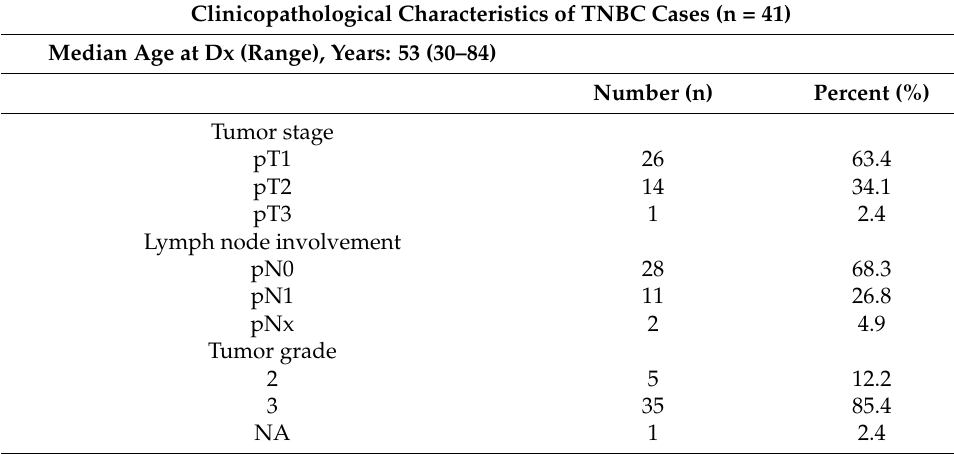
Table 1. Clinicopathological characteristics of TNBC patients included in the study (n =